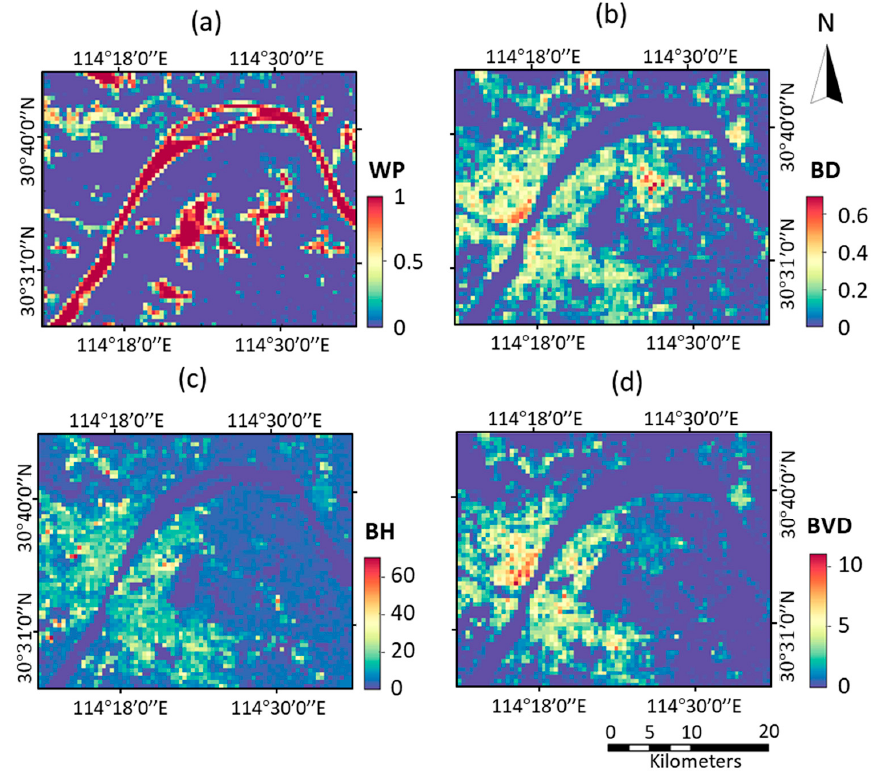
Figure 5. The spatial distributions of the indicators preserving indistinctive seasonal variations, taking summer as an example. ( a ) WP, ( b ) BD, ( c ) BH and ( d )